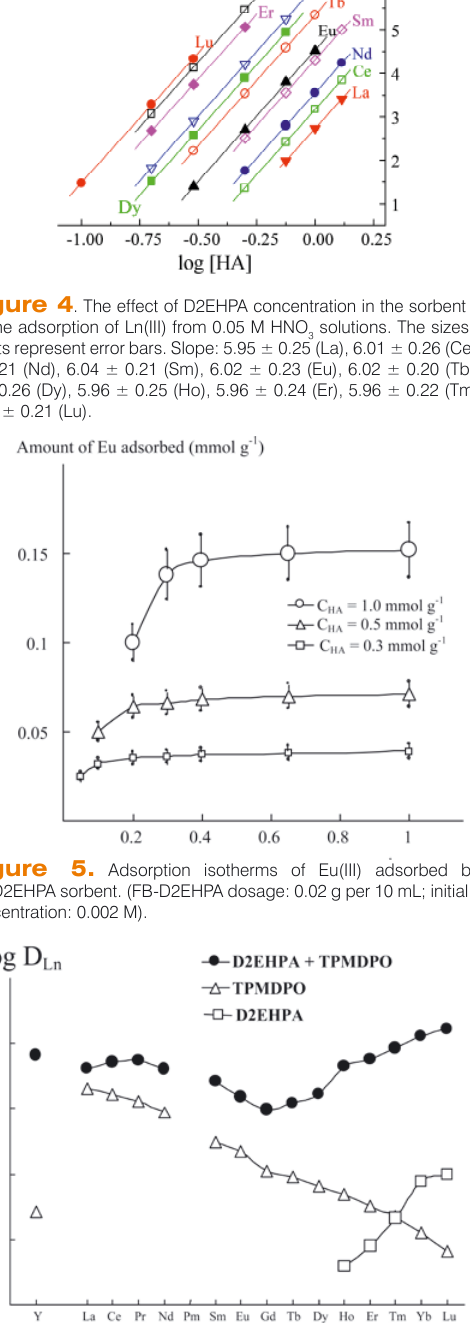
Figure 6. The adsorption of lanthanides and yttrium from 0.1 M HNO by FB impregnated with D2EHPA, TPMDPO, and a mixture of 3 D2EHPA and TPMDPO (sorbent dosage: 0.1 g per 10 mL; concentration of D2EHPA and TPMDPO: 0.35 mmol g -1 ). The sizes of the points repre- sent error bars.